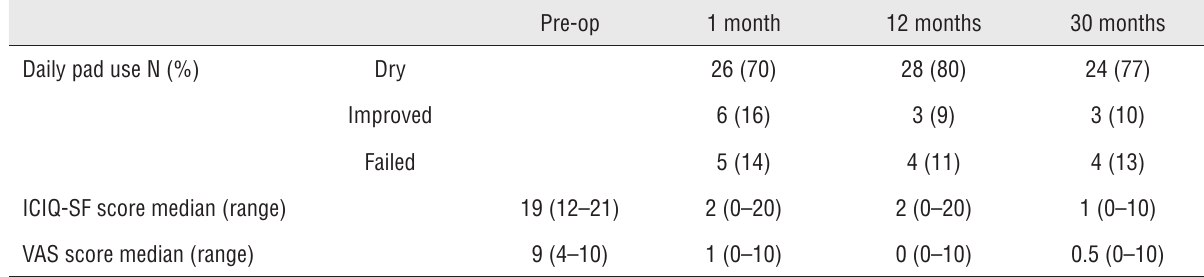
Table 2 - Postoperative